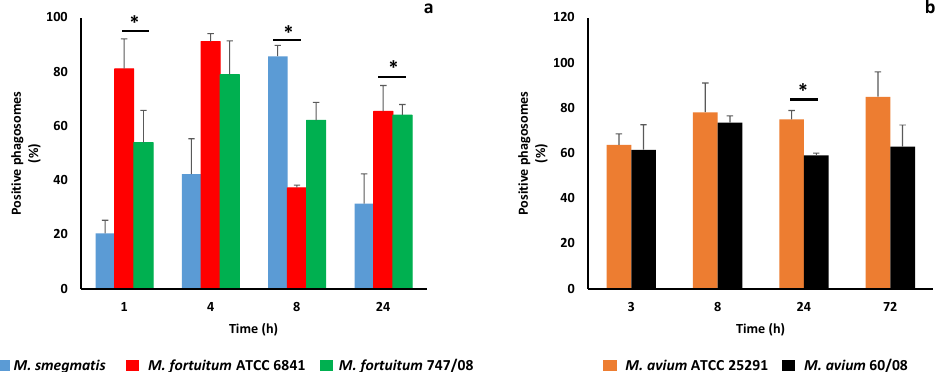
Figure 2. Acidification of phagosomes containing nontuberculous mycobacteria. Acquisition of Lysotracker by rapidly growing mycobacteria ( a ) and slowly growing mycobacteria ( b ) was used to assess phagosome acidification. (* p <